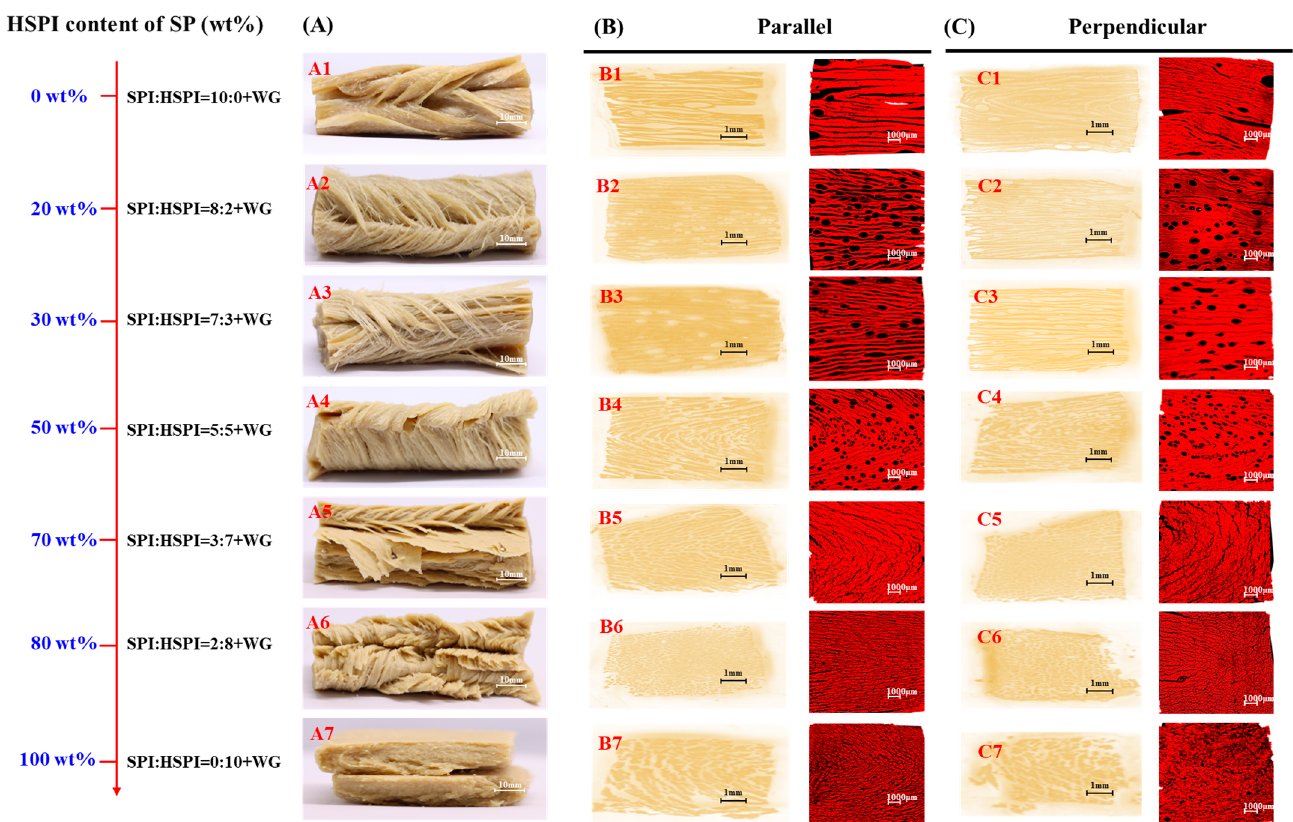
Figure 5. Macrostructure ( A ) and CLSM parallel ( B ) or perpendicular ( C ) to the extrusion direction of the extrudates (SPI: HSPI = 10:0 + WG, SPI: HSPI = 8:2 + WG, SPI: HSPI = 7:3 + WG, SPI: HSPI = 5:5 + WG, SPI: HSPI = 3:7 + WG, SPI: HSPI = 2:8 + WG, and SPI: HSPI = 0:10 + WG).